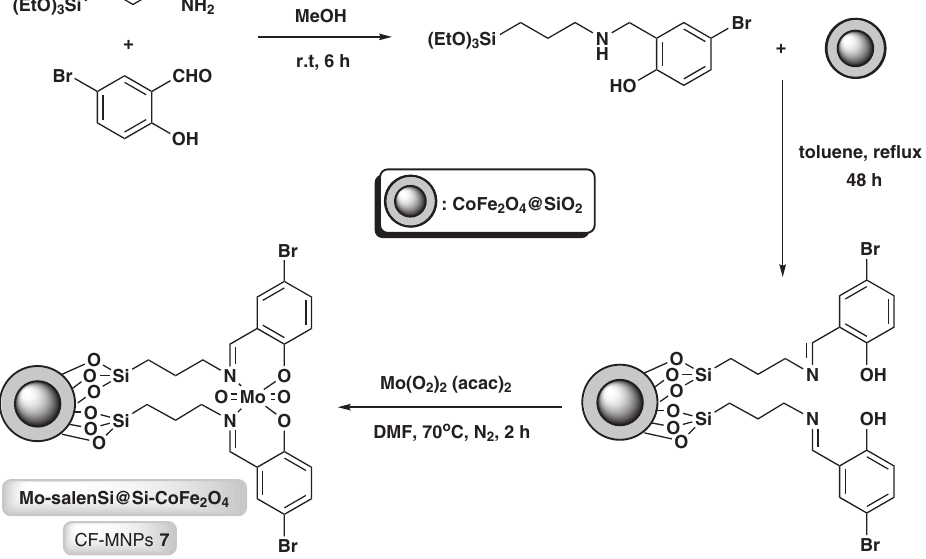
Scheme 6: Stepwise preparation of Schiff base molybdenum complex immobilized on silica-coated cobalt ferrite nanoparticles (CF-MNPs 7 ).